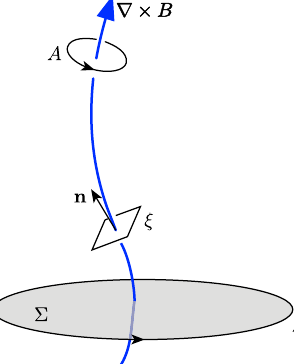
FIG. 7. Anatomy of an umbilic line. Top: The vector ∇ × B is tangent to generic umbilic lines, giving them a natural